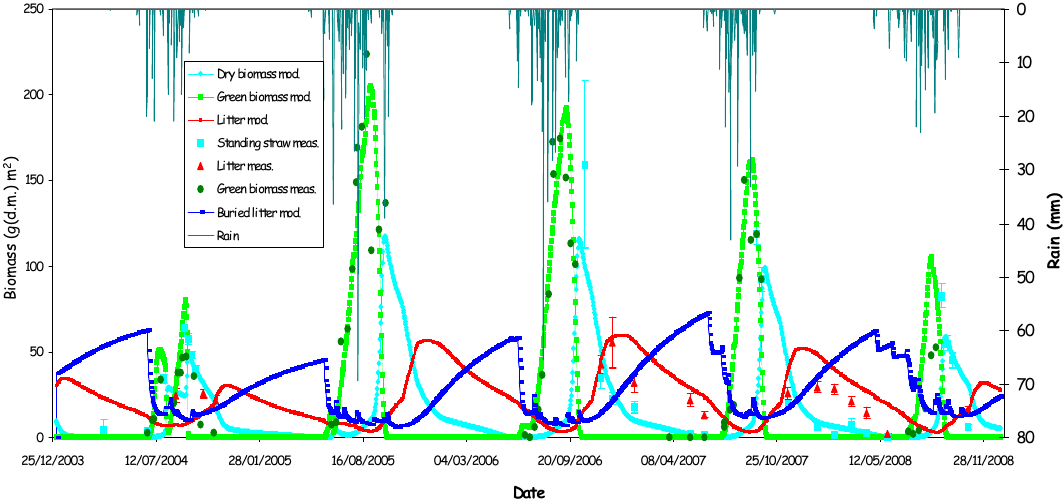
Figure 4. Green biomass in green, dry biomass in light blue, surface litter in red, buried litter in dark blue (line for the model, dots for measurements), in g ( d . m .) m − 2 . Standard deviations are indicated for the measurements. Rain in blue-grey in mm, for years 2004 to 2008 at Agoufou.